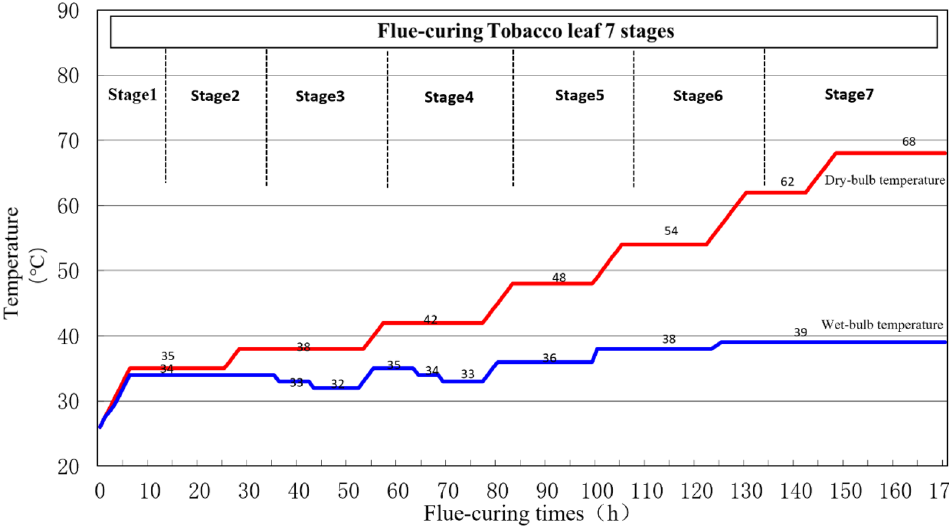
Figure 2. Dry-ball temperature set and wet-ball temperature degradation flue-curing procedure (DSWD) used in bulk curing barns in Yuxi tobacco-growing